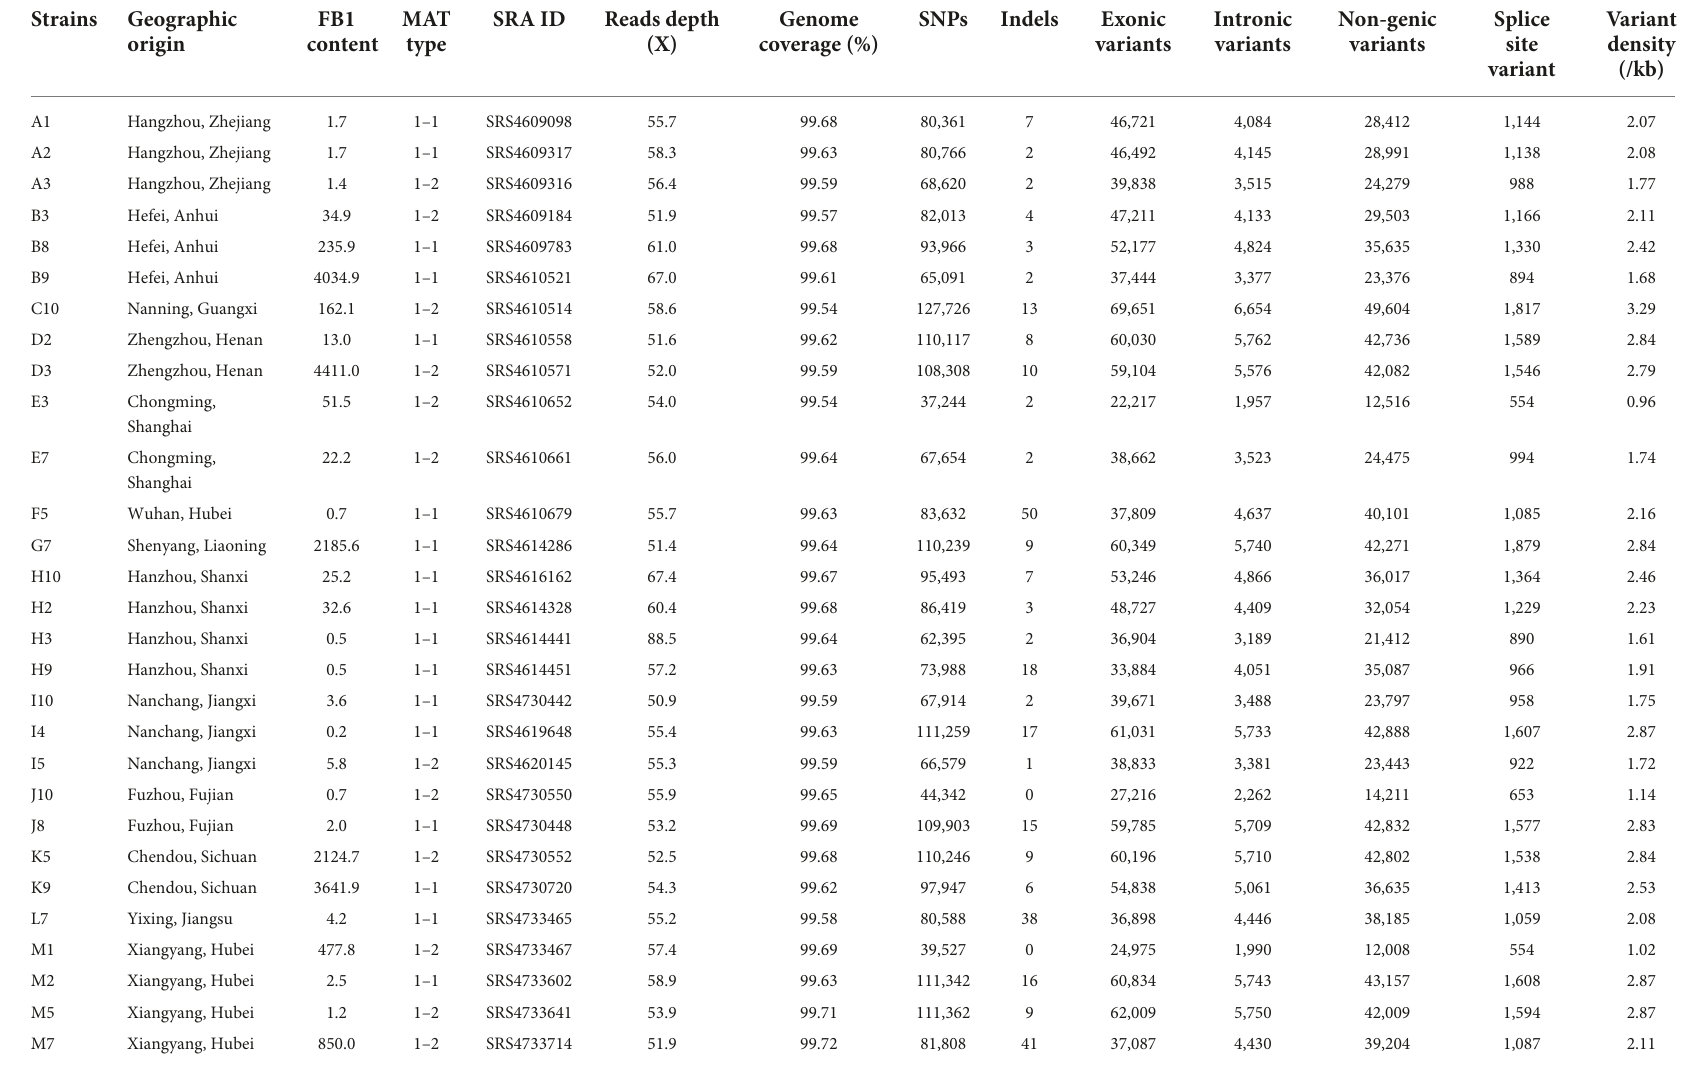
TABLE 1 Fumonisin FB1 production and variant calling statistics of Fusarium